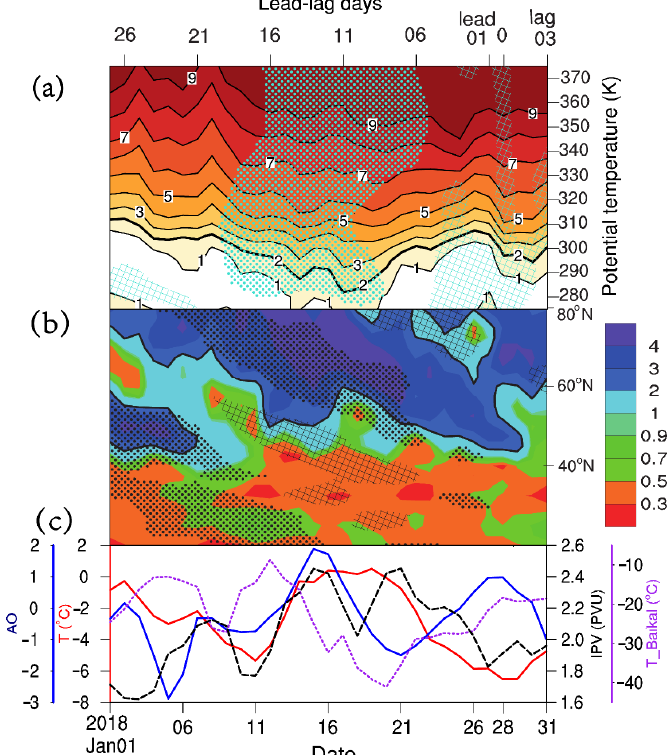
Figure 4. ( a ) Isentropic surface–time profile of area (60–70° N, 80–100° E) in the high PV source (located on the northwestern side of Lake Baikal (80–120° E, 50–70° N)) in January 2018, overlapped lead and lag correlations. The dot (negative correlation) and the mesh (positive correlation) areas represent significant correlations above a 0.10 significance level. Lead01–27 represents that the PV series lead surface temperature series of China (from 1 January to 9 February) by 1 to 27 days, respectively; lag0–03 represents that the PV lag temperature by 0 to 3 days, respectively. The lowest temperature date, 28 January, is the base date, indicated by the thick red dashed straight line. The thick solid contours in ( a ) and ( b ) are 2PVU. ( b ) Same as ( a ), but for the 305 K 90° E latitude-time profile. (c) Daily series of surface temperature averaged over China (T) (red curve, units: °C), 305 K PV averaged over the high PV source (80–120° E, 50–70° N) (isentropic PV) (black dotted curve, units: PVU), 1000hPa temperature at the point (60° N, 100° E) (T_Baikal) (purple dotted curve, units: °C) and AO index (blue curve) in January.